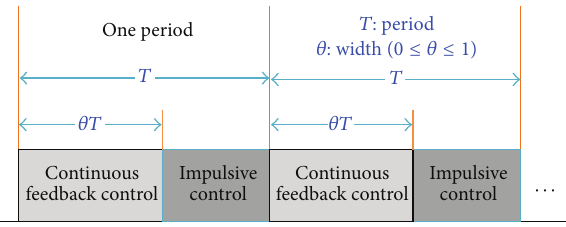
Figure 1: Sketch map of the sliding intermittent